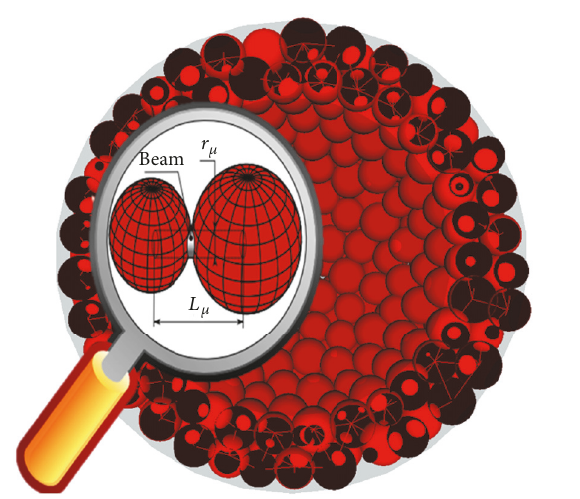
Figure 3: Hollow sphere modelled with discrete elements and cohesive